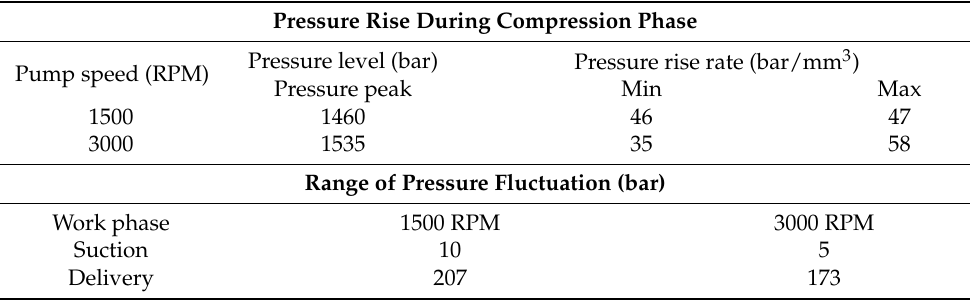
Table 6. Pressure behavior during suction, compression, and delivery